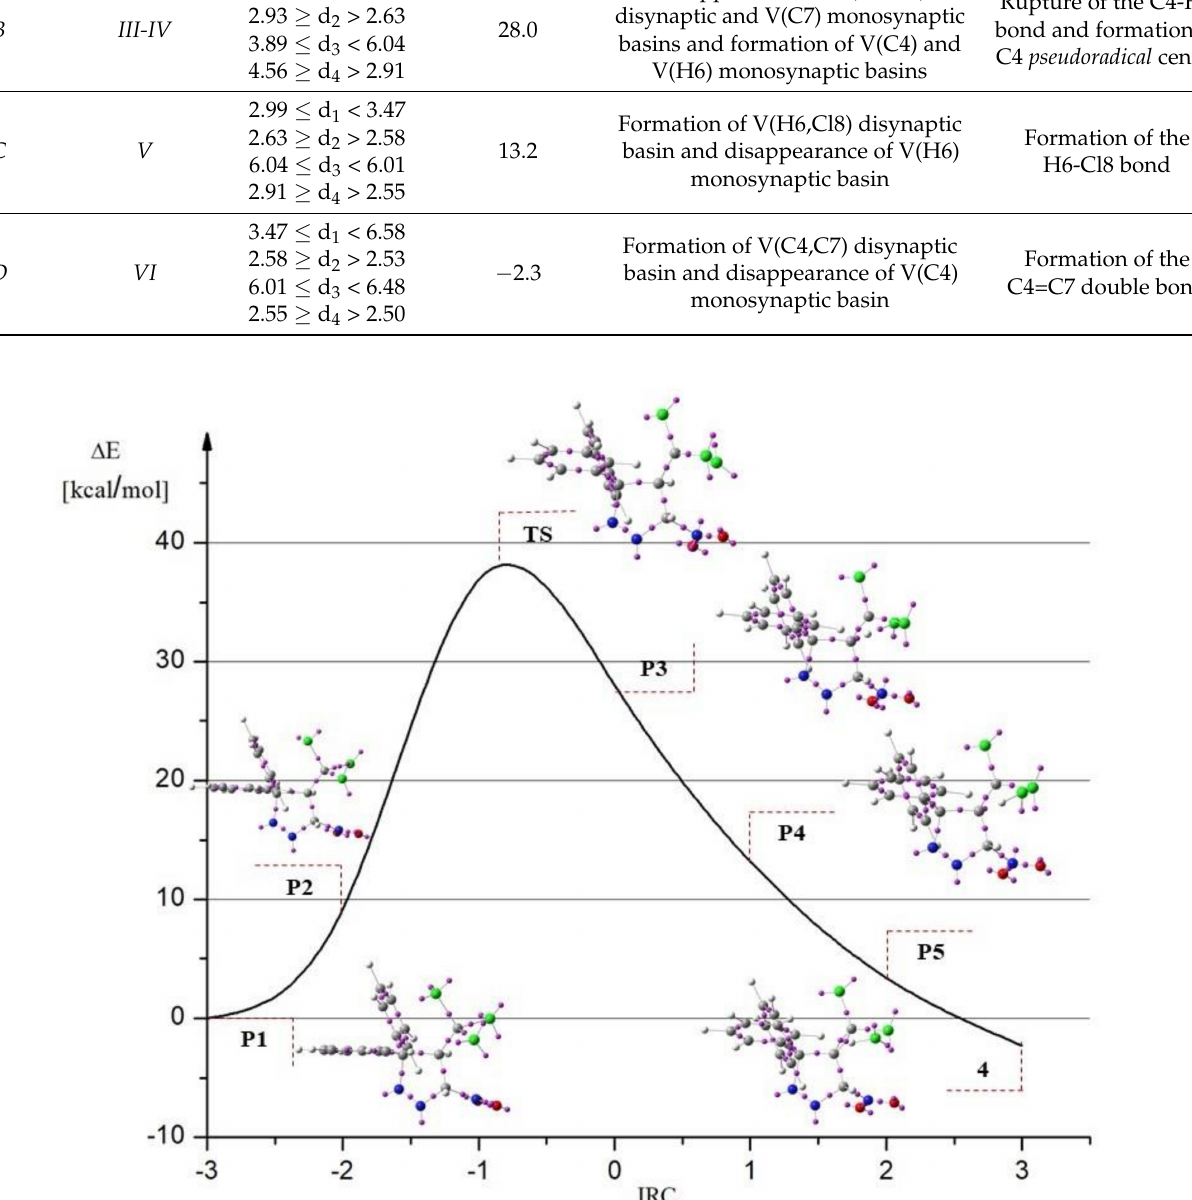
Figure 2. B3LYP(PCM)/6-31G(d) IRC profile including the ELF attractor positions for the most relevant points of the dehydrochlorination of 3 and relative electronic